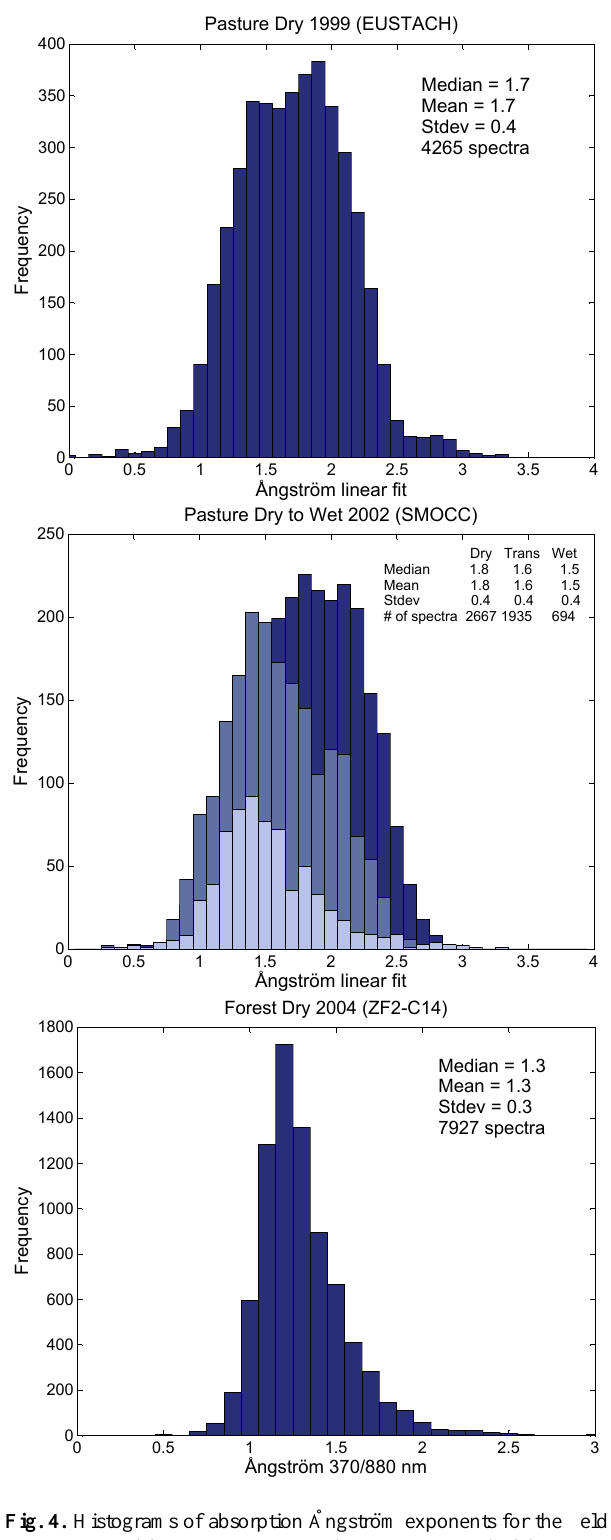
Fig. 4. Histograms of absorption ˚Angstr¨om exponents for the field experiments: (a) Pasture Dry 1999 (LBA/EUSTACH); (b) Pasture Dry to Wet 2002 (LBA/SMOCC); (c) Forest Dry 2004 (LBA/ZF2- C14). The typical uncertainty in ˚a abs is ± 20% (refer to Sect. 2.4).